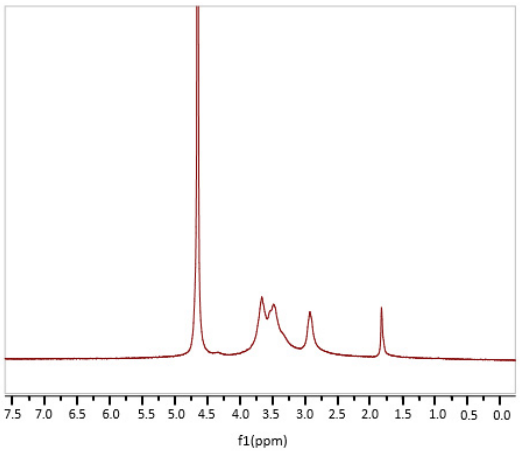
Figure 1. 1 H-NMR chitosan spectrum.